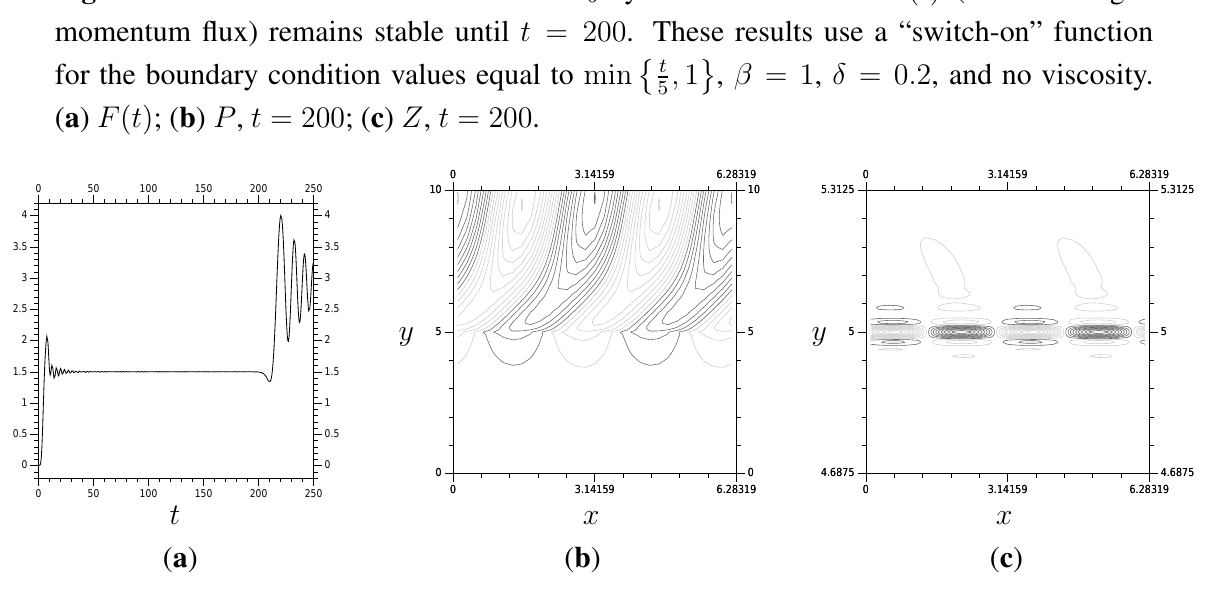
Figure 13. The results from a linear V − system. Notice that F ( t ) remains stable until 5 t = 100 , where Z is following the same pattern seen in Figure 12c. These results are based around the same problem as those in Figure 12, just with a different resolution. ( a ) F ( t ) ; ( b ) P , t = 100 ; ( c ) Z , t = 100